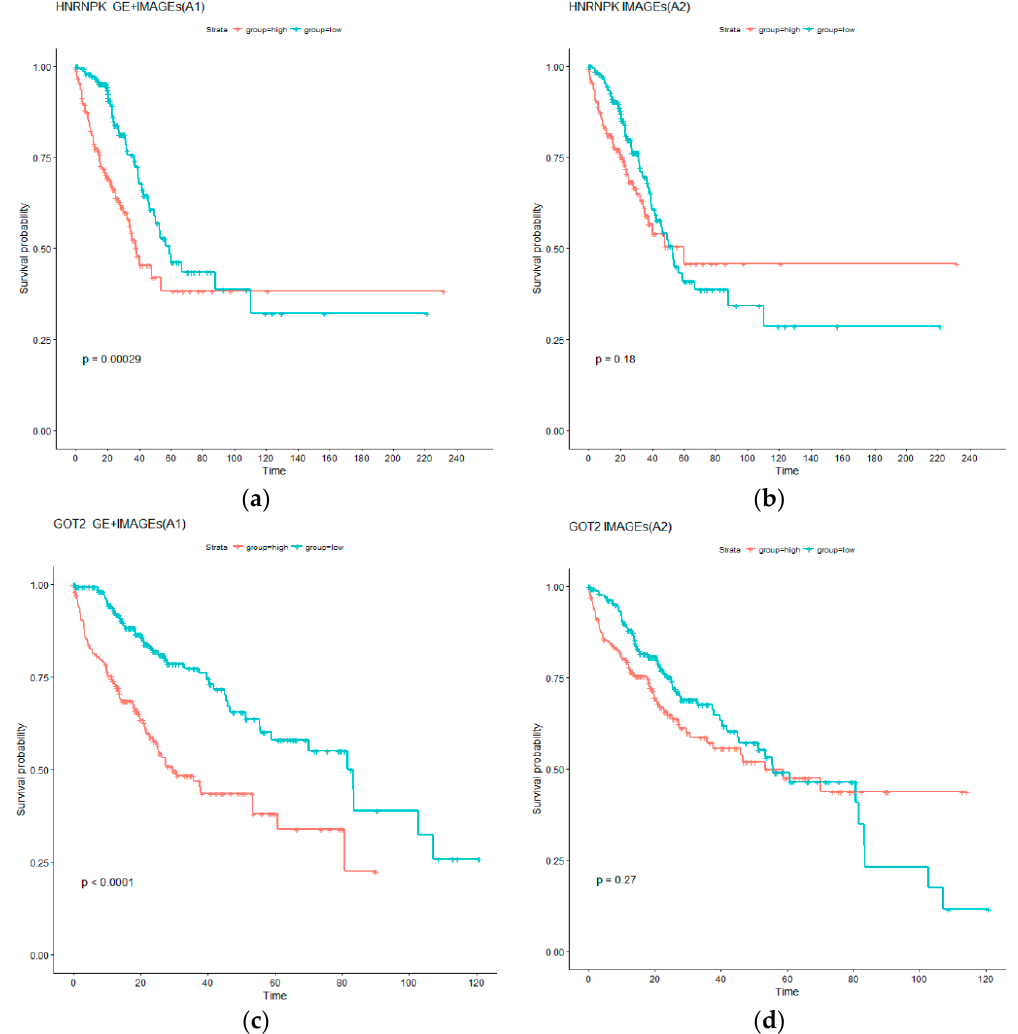
Figure 3. Kaplan–Meier (KM) curves for low (blue) and high (red) risk groups under models A1 and A2. ( a , b ) for LUAD: Gene HNRNPK as well as selected imaging features (A1), and only selected imaging features (A2). ( c , d ) for LIHC: Gene GOT2 as well as selected imaging features (A1), and only selected imaging features (A2). p values are computed from log rank